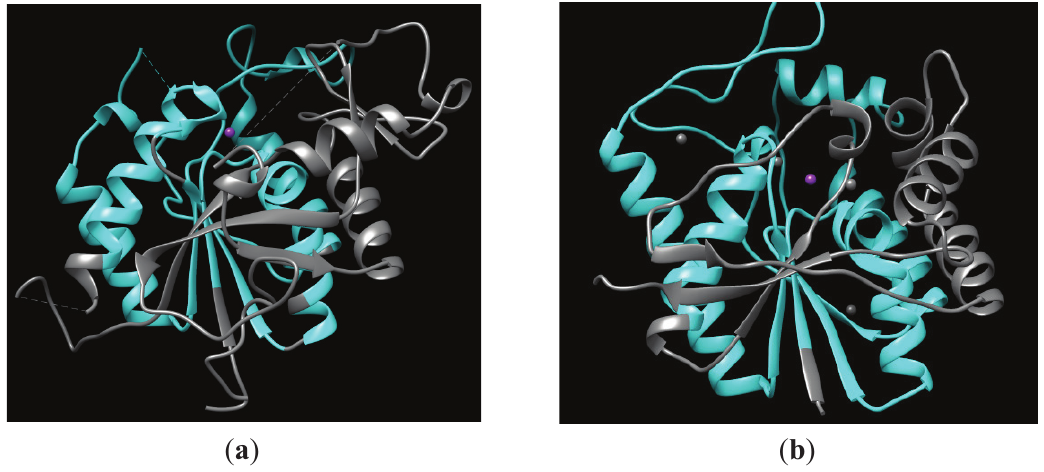
Figure 1. Representative structures of LmbE-like enzymes containing the PIG-L domain. ( a ) Structure of MshB (PDB 4EWL [5]) with the PIG-L domain (residues 8–158) shown in cyan. The catalytic zinc ion is represented as a purple sphere; ( b ) Structure of teicoplanin deacetylase (PDB 3DFM [6]) with the PIG-L domain (residues 11–175) shown in cyan. The catalytic zinc ion is represented as a purple sphere, while non-catalytic zinc ions are represented as gray spheres.